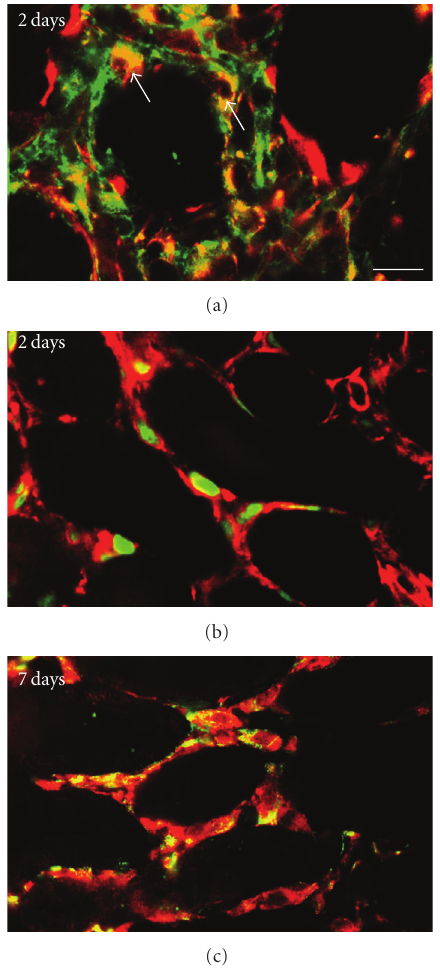
Figure 8: (a) Double label immunofluorescence for nestin (green) and vimentin (red) in an ischemic kidney two days after reper- fusion. Interstitial cells coexpressing both markers appear yellow (arrows). (b) Double immunostaining for vimentin (red) and PCNA nuclei (green) two days after reperfusion. PCNA-positive nuclei were observed in interstitial fusiform vimentin-positive cells. (c) Double label immunofluorescence for α -SMA (red) and nestin (green) in ischemic kidney one week after reperfusion. Most of interstitial cells surrounding cystic tubules coexpressed both markers (yellow). Scale bar. 18 μ m: (a, b,